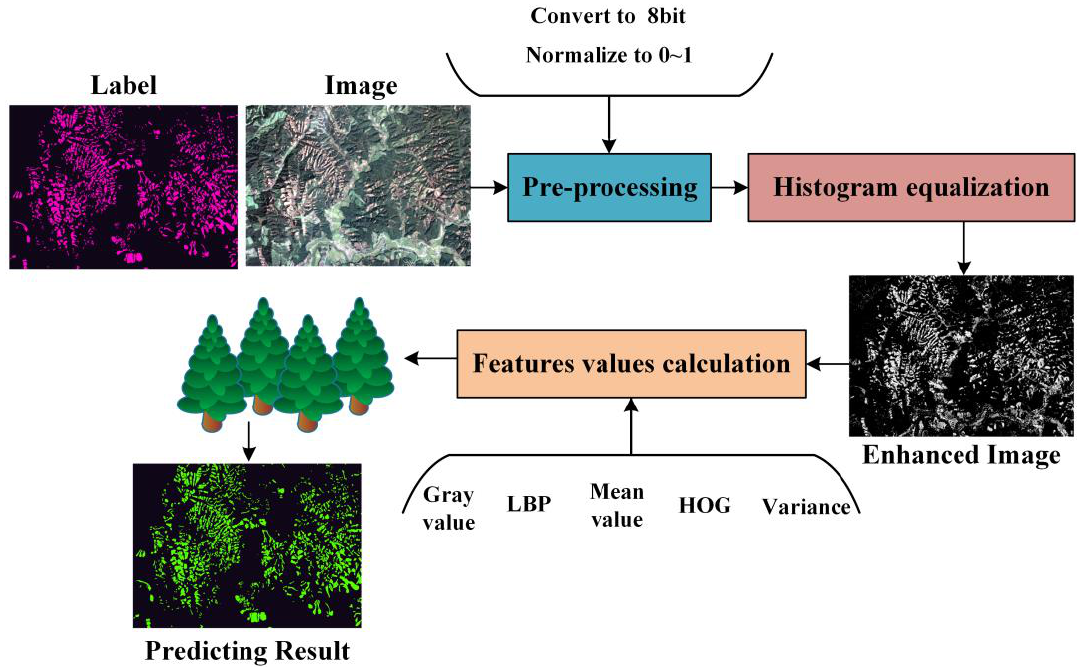
Figure 4. Detailed procedures in RF. The input is the labeled image that is subsequently normalized and equalized. After training, the model outputs the predicting results and calculates the accuracy.